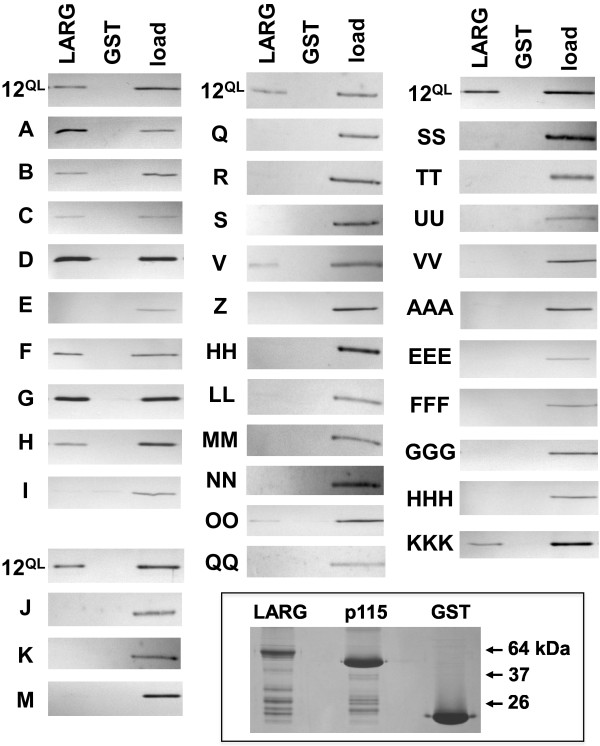
In vitro interaction of Gα12 mutants with LARG. Immunoblot results for all LARG binding-impaired Gα12 cassette mutants and selected other mutants are shown. HEK293 cells were transfected with the indicated plasmids (7.0 μg per 10-cm plate) and lysates were prepared for co-precipitation assays as described in Methods. Prior to this step, 5% of each lysate was set aside as starting material (load). Pulldown experiments were performed on 7–9 mutants per experiment, plus myc-Gα12QL as a positive control, using equal amounts of GST-LARG-RH (LARG) immobilized on glutathione-sepharose. Immobilized GST was utilized in parallel as a negative control. For all experimental samples, 20% of the volume was analyzed by SDS-PAGE and Coomassie blue staining to verify equal amounts of GST-LARG-RH and GST proteins in the precipitates (data not shown). Immunoblots displayed in this figure are representative of at least three trials per cassette mutant, except for mutants A-D, F-H, V, and KKK that showed minimal impairment in LARG binding after two trials. (Inset) Coomassie blue analysis of GST-fusion constructs expressed in bacteria and immobilized on glutathione-sepharose: GST-LARG-RH (LARG), GST-p115-RH (p115), and GST alone. Molecular weight standards (in kDa) are indicated at right.